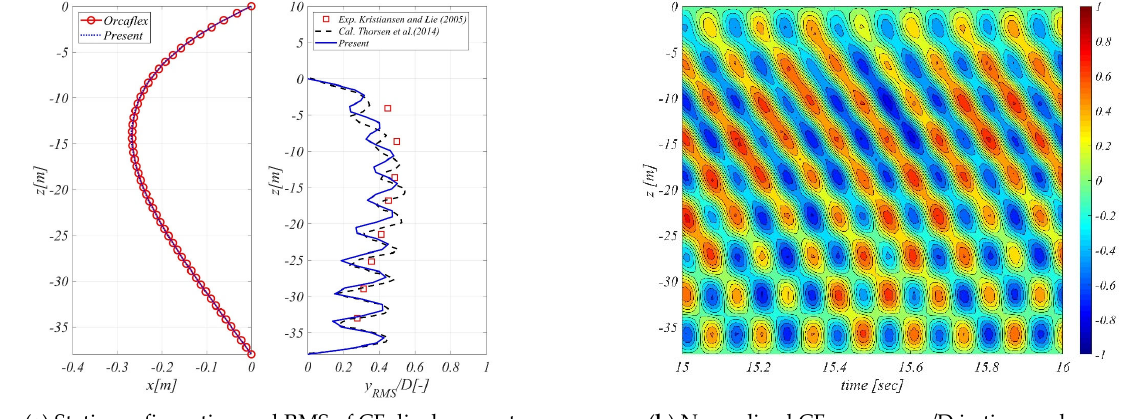
Figure 19. Static configuration and cross flow displacement with shear current ( U max = 1.3 m/s) [5,25].